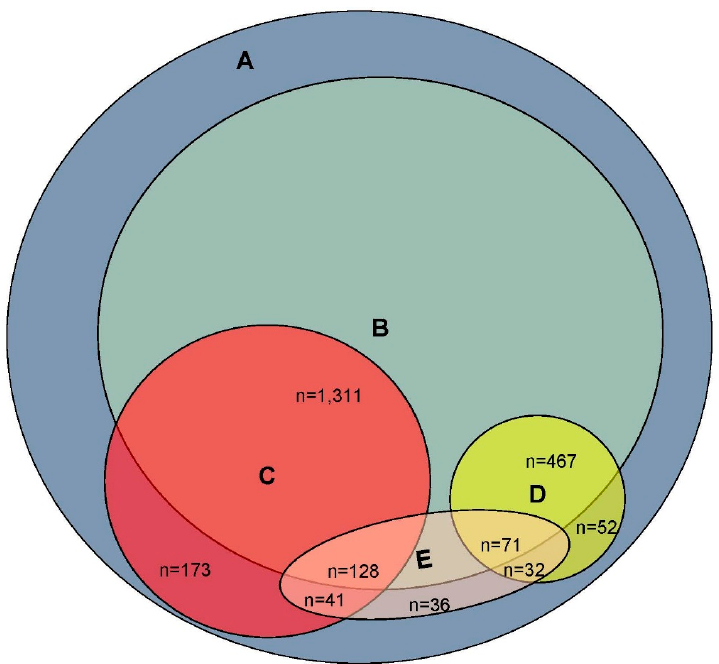
Figure 1. Visual representation of survey respondents classified as (Circle A) Total Valid Reports ( N = 5,769), (Circle B) No Neurologic Disorders ( N = 4,237), (Circle C) Suspected Mild Cognitive Impairment ( N = 1,653), (Circle D) Suspected Dementia ( N = 622), and (Ellipse E) Report of Severe Memory Problems ( N = 522). Size of each figure and area of overlap is approximately proportionate to set size.